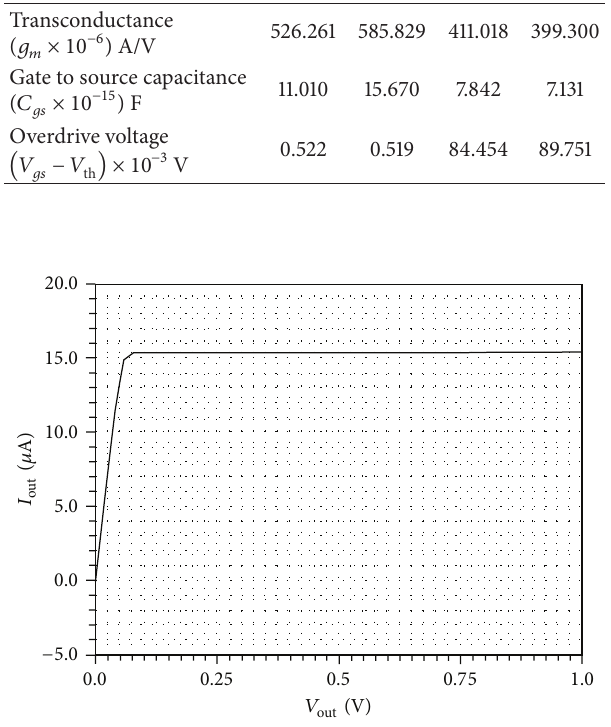
Figure 10: Variation of output current with respect to output voltage of the proposed current mirror.